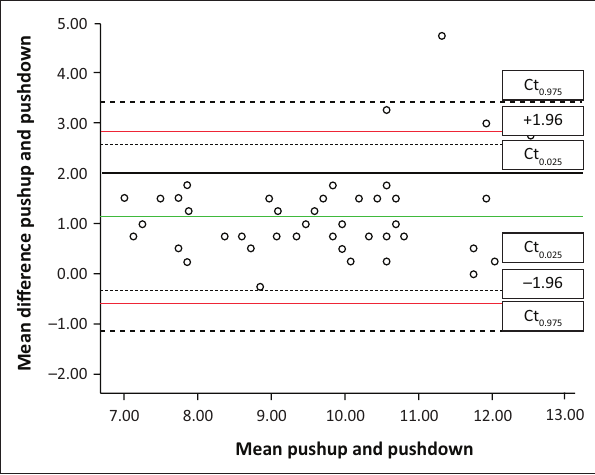
FIGURE 5: A Bland–Altman plot of differences in push-up minus push-down measurements against the means for paired measurements (for each participant concerned) is indicated, together with 95 % confidence intervals about the upper and lower limits of agreement. The limits of agreement are indicated by the red lines, while the dashed and dotted lines are 0.025 (inner) and 0.975 (outer) confidence intervals. There is fairly good agreement between the push-up and push-down measurements. The mean difference is slightly larger than 1 D (see Table 2), and the width of the 95 % LoA interval is approximately 3 D.